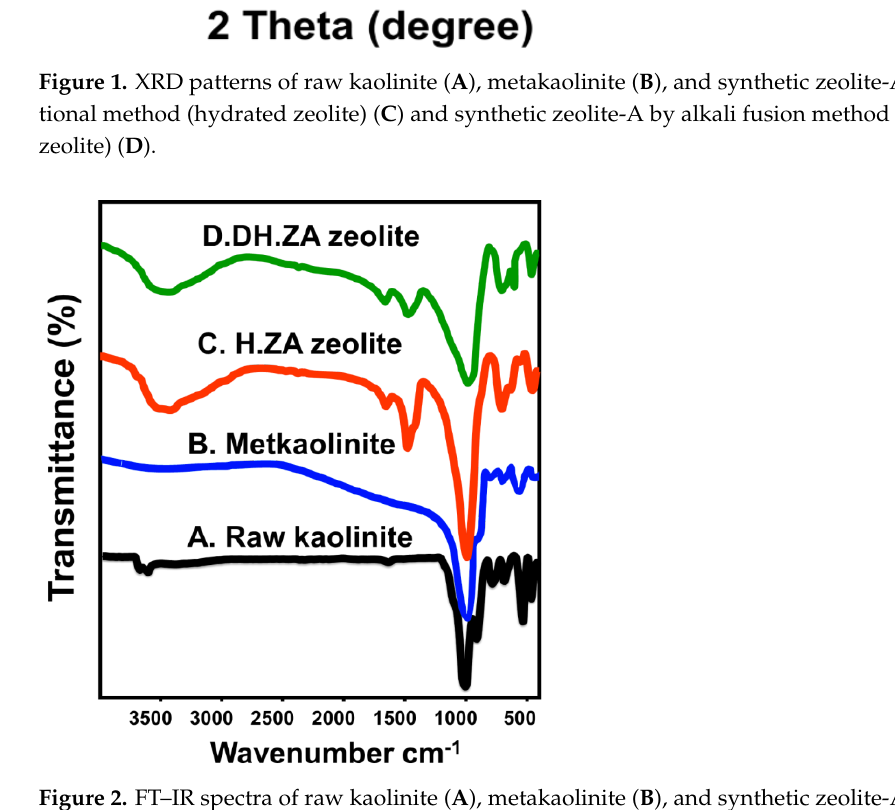
Figure 2. FT–IR spectra of raw kaolinite ( A ), metakaolinite ( B ), and synthetic zeolite-A by conven- tional method (hydrated zeolite) ( C ) and synthetic zeolite-A by alkali fusion method (dehydrated zeolite) ( D ).